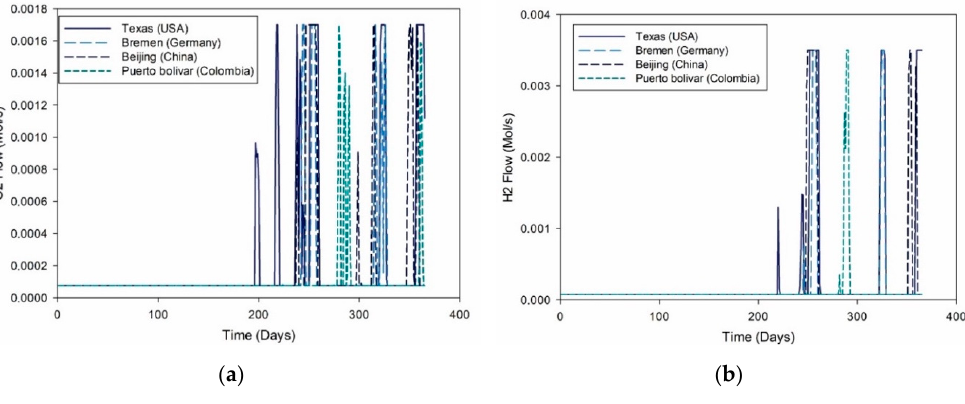
Figure 9. Flow for charge profile 2 for ( a ) O 2 and ( b ) H 2 .